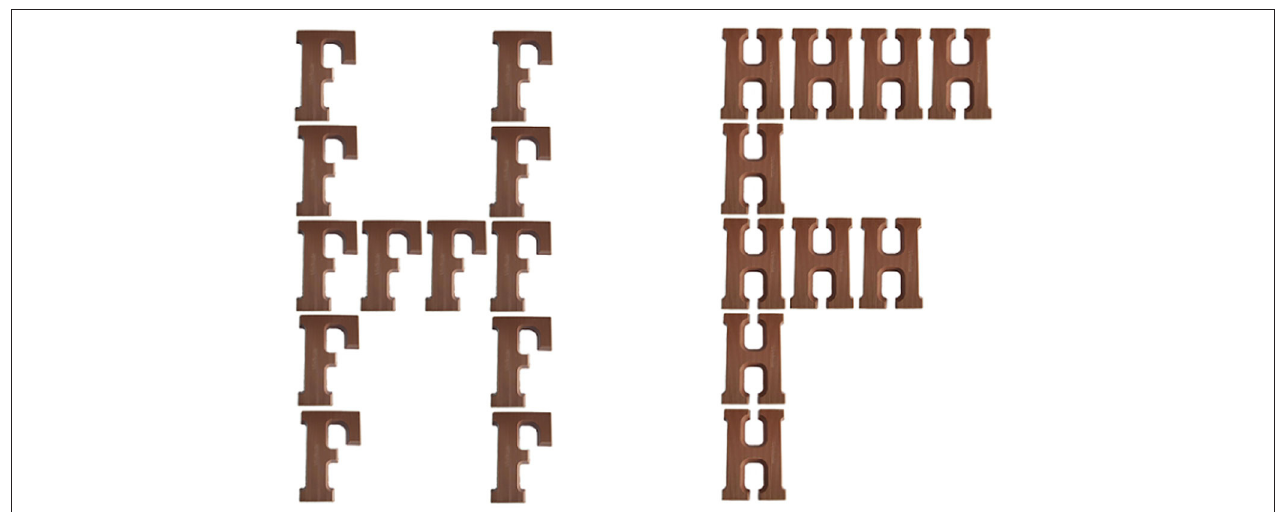
FIGURE 1 | Sample pictures of “chocolate” Navon letters (Study 2). Left: sample stimulus used in the global condition; right: sample stimulus used in the local condition.